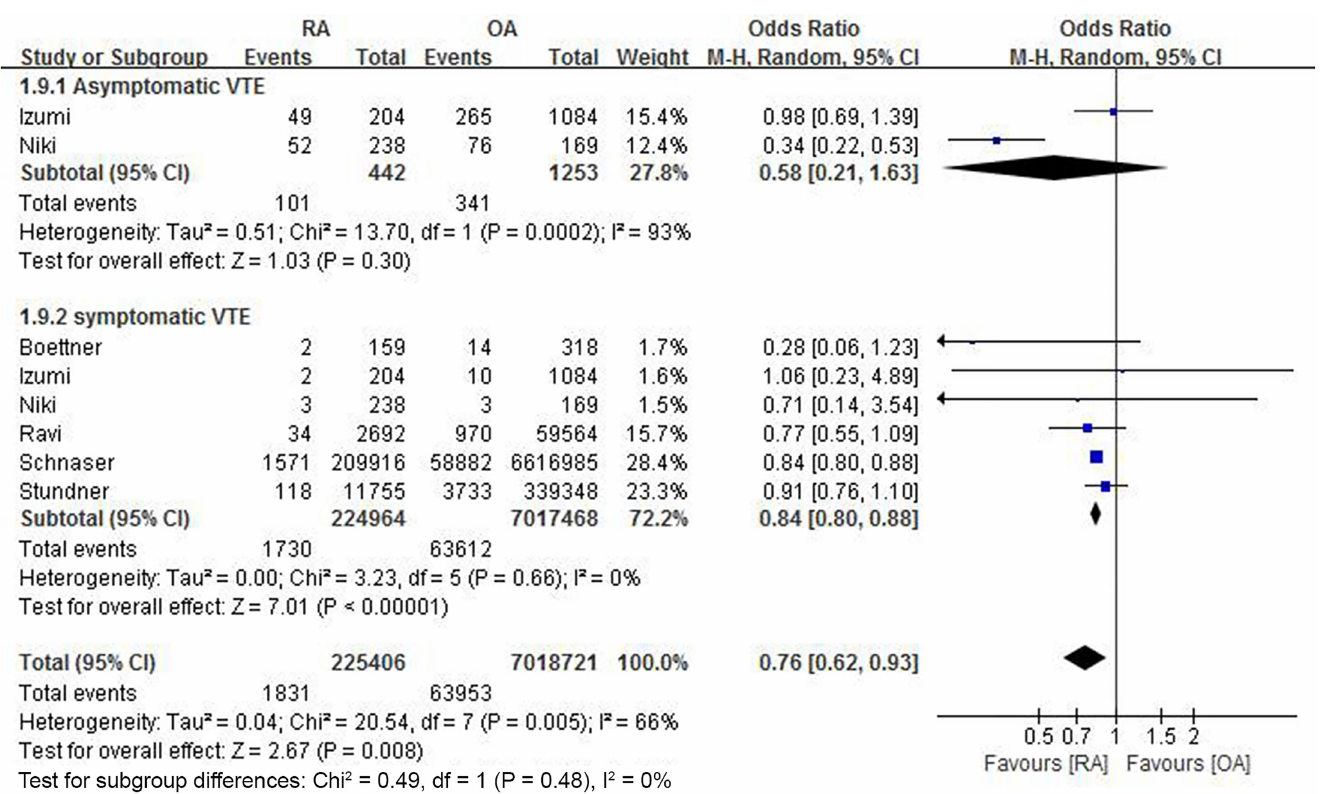
Fig 3. Forest plot showing differences in the rate of venous thromboembolism after total knee arthroplasty between patients with rheumatoid arthritis (RA) and osteoarthritis (OA).